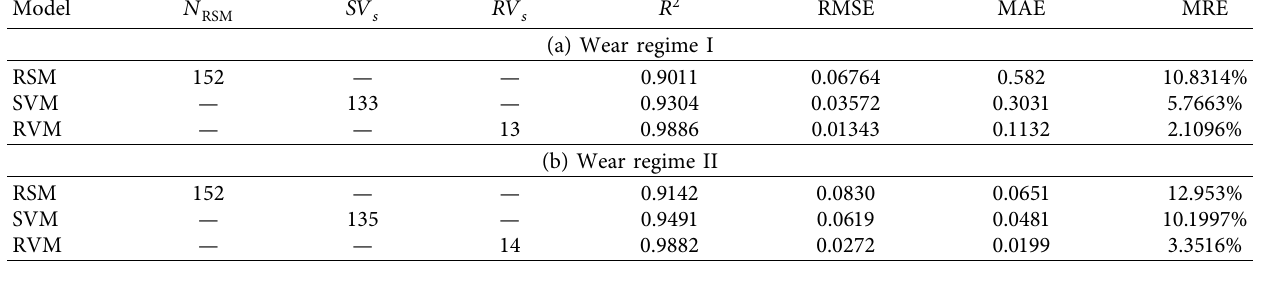
Table 2: Prediction performance indexes of different prediction models based on simulation data. Model